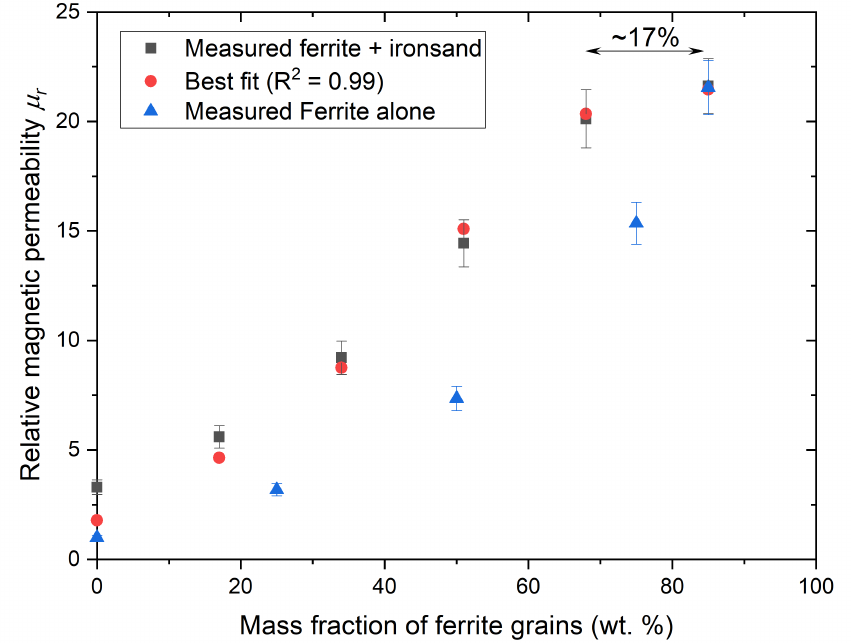
Figure 6. Evolution of the magnetic permeability with different loadings of ferrite and ironsand. The horizontal axis gives the fraction of ferrite grains. The fraction of ironsand is complementary to make a total magnetic filler loading of „ 80